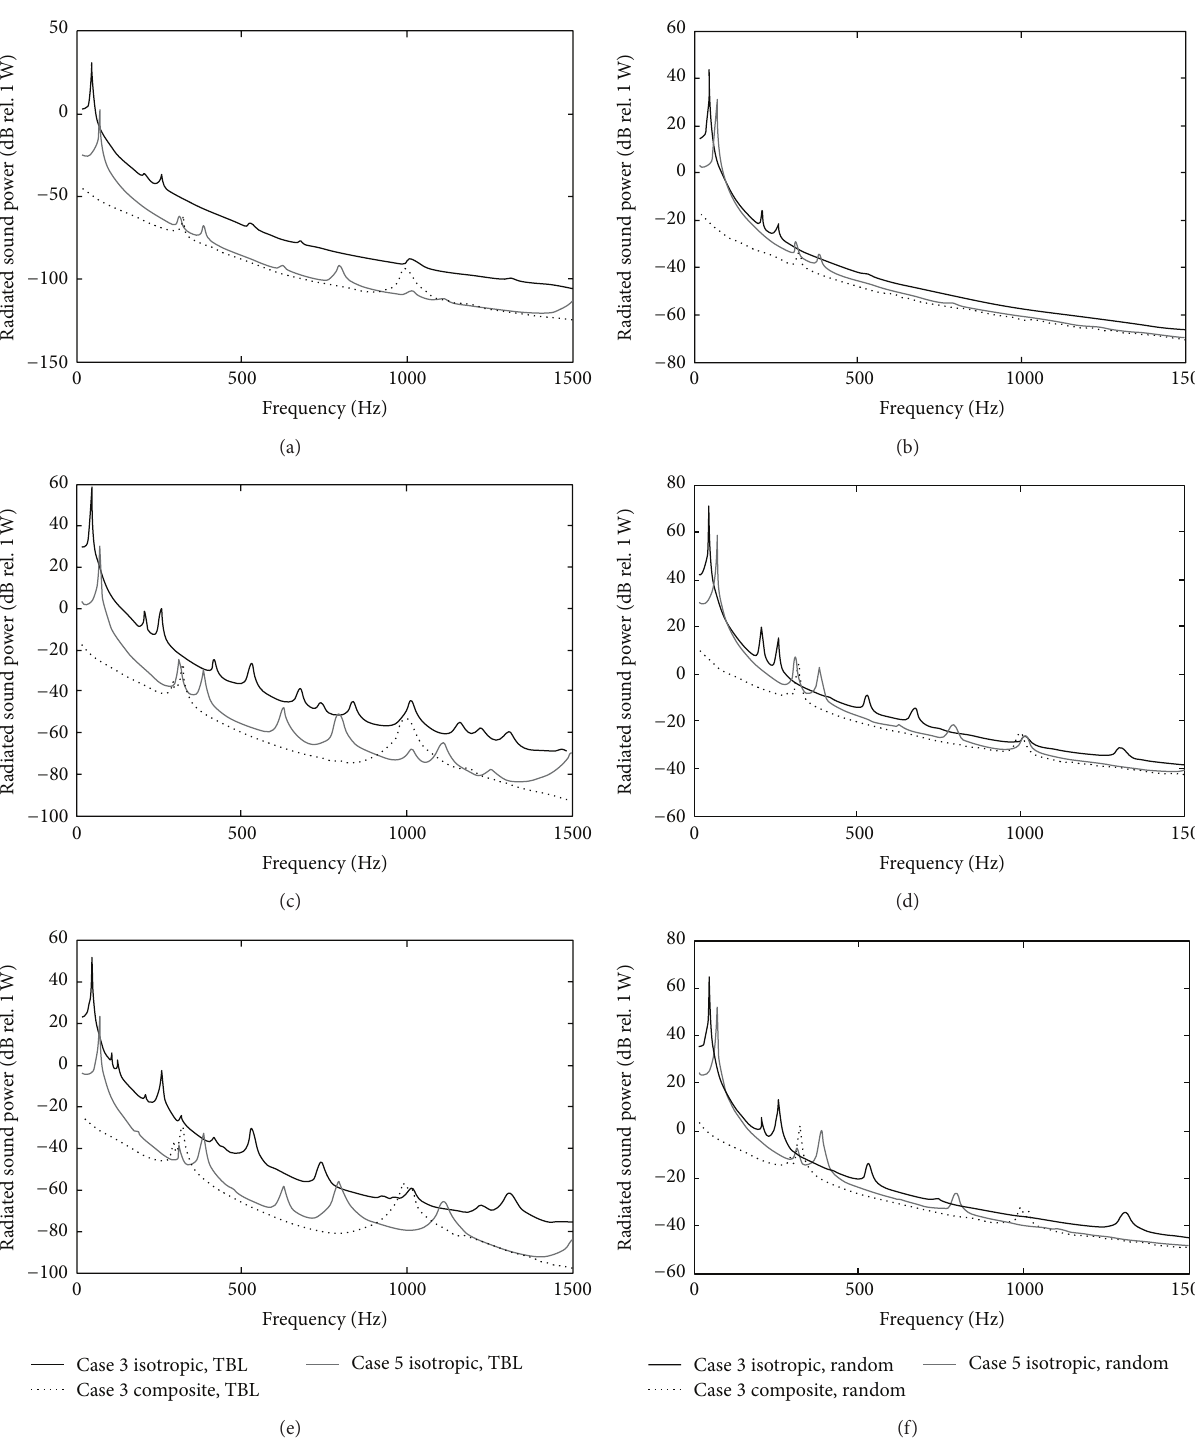
Figure 8: Comparison of radiated sound power results, for Case 3 composite panel versus Cases 3 and 5 isotropic panels: (a) and (b) overall panel RSP; (c) and (d) RSP near surface location (𝑥 1 ,𝑦 1 ) = (0.5𝑎, 0.5𝑏) ; (e) and (f) RSP near location (𝑥 2 ,𝑦 2 ) = (0.3𝑎, 0.2𝑏)